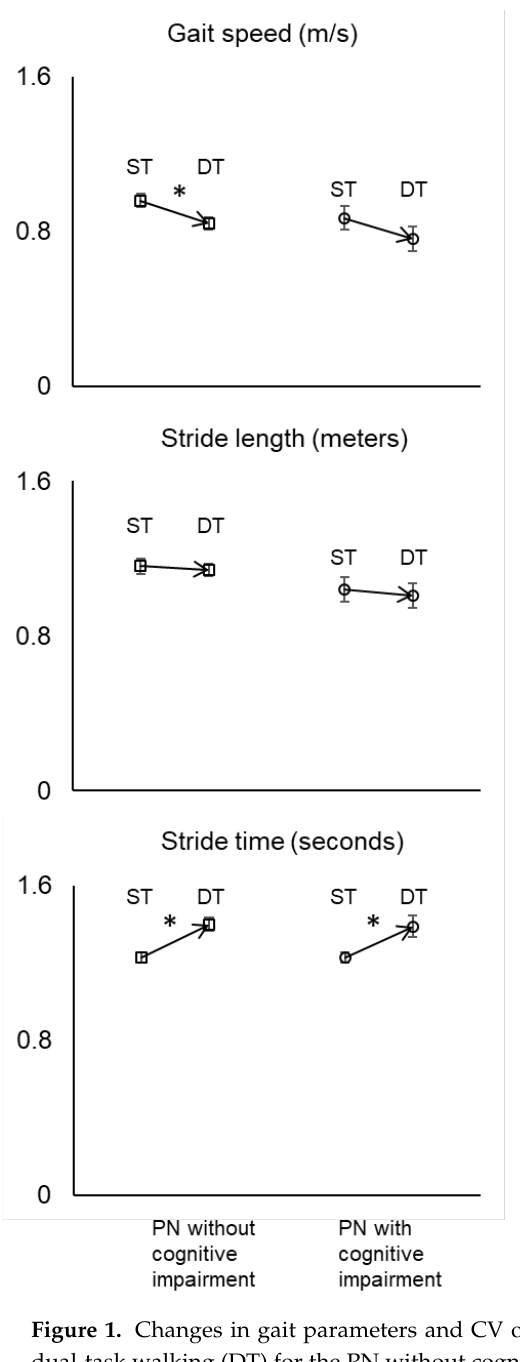
Figure 1. Changes in gait parameters and CV of the parameters from single-task walking (ST) to dual-task walking (DT) for the PN without cognitive impairment group and the PN with cognitive impairment group. Asterisks denote significant changes in DT from ST (all p < 0.05). The cross denotes a marginal change in DT from ST ( p = 0.063). All significant changes were after accounting for the effects of age, body mass index, and sex.